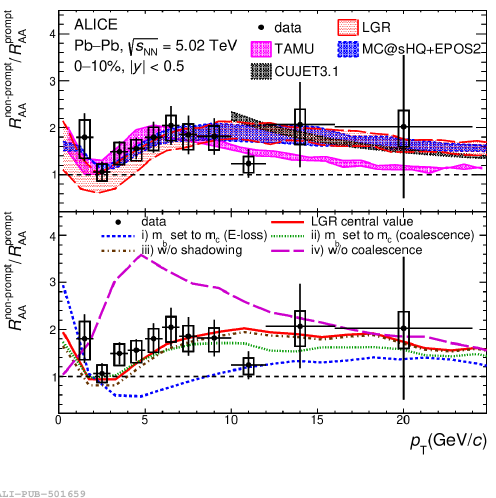
Figure 1. Non-prompt to prompt D 0 -meson R AA ratio [3] as a function of p T in central Pb–Pb collisions at √ s NN = 5 . 02 TeV, compared to model predictions [4–8] (top), and to di ff erent modifications of LGR calculations